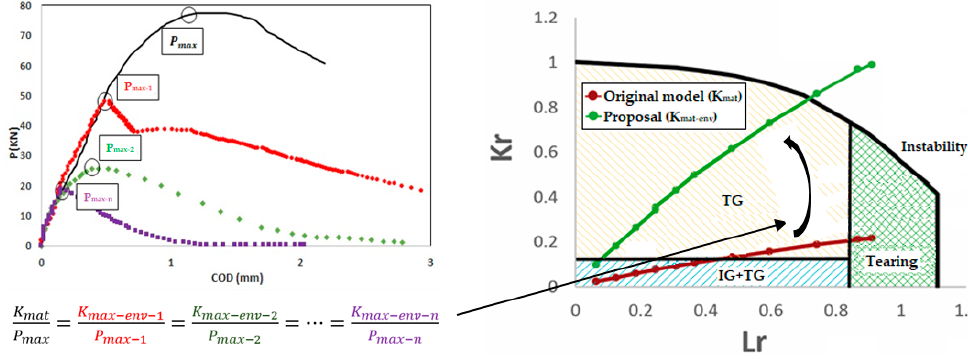
Figure 11. Proposal for the crack propagation crack representation on the FAD.